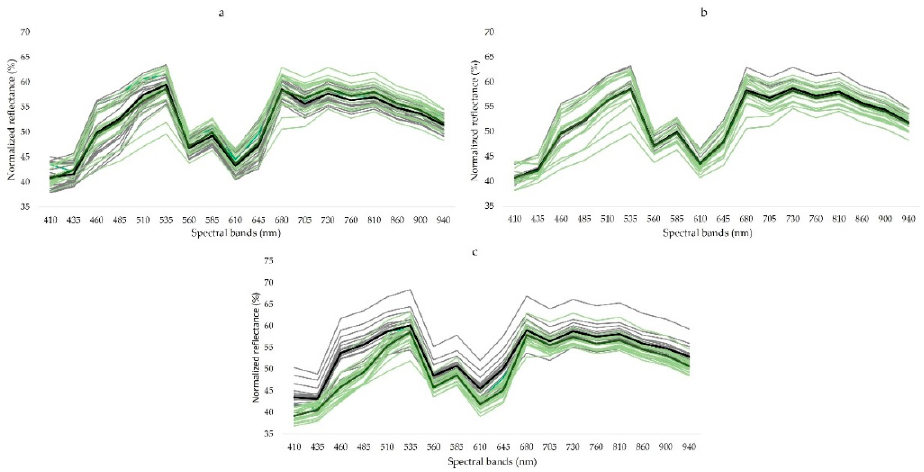
Figure 4. Reflectance responses of olive fruits in the upper limit (grey) and the lower limit (green) of moisture ( a ), fat content ( b ), and acidity ( c ). Each graph includes 40 samples (corresponding to approximately the 5th and above the 95th percentile respectively for each parameter). Furthermore, the mean reflectance curve of the 20 samples in the upper limit (black) and the 20 samples in the lower limit (dark green) are represented.